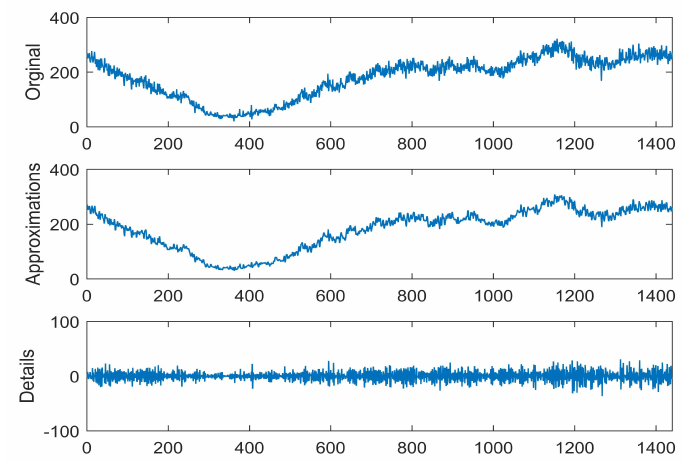
Figure 8. Decomposition effect of the MODWT